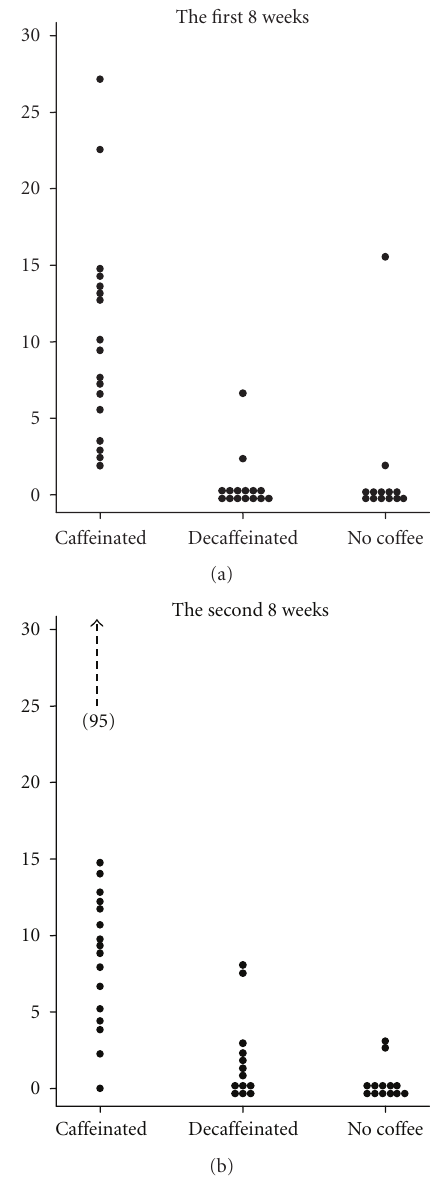
Figure 2: Ca ff eine concentrations ( μ M) in saliva collected at unannounced visits in the first 8 weeks (a) and the second 8 weeks (b) during the